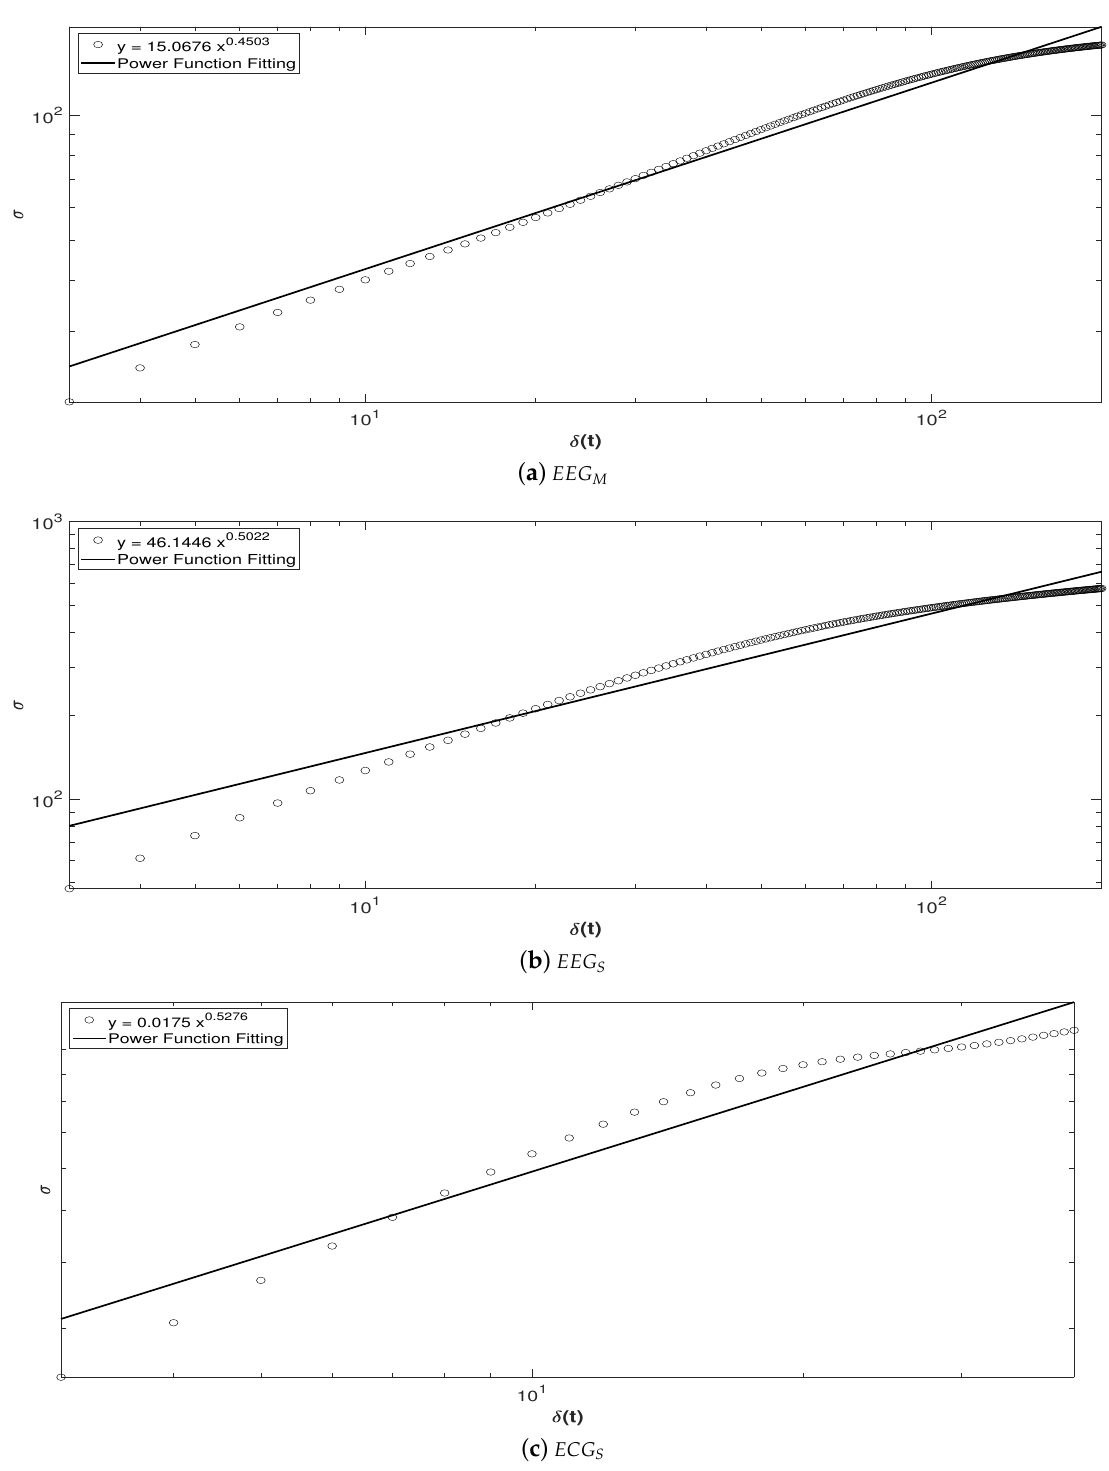
Figure 30. Self-Affine Analysis of: ( a ) EEG M in an intervention patient, ( b ) EEG S in a bottlenose dolphin, and ( c ) ECG S in an intervention